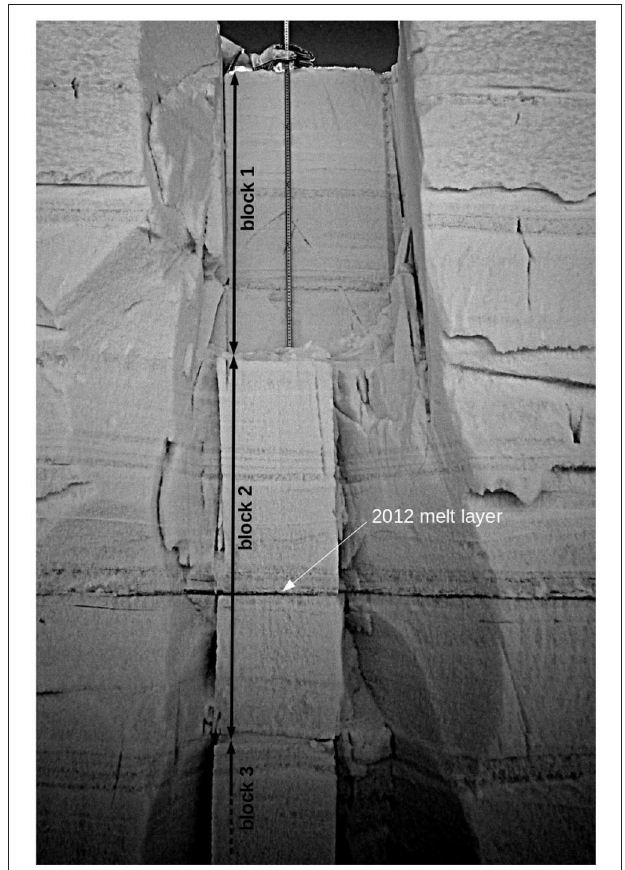
FIGURE 1 | Near-infrared picture (qualitative) of the snow wall that highlights the snowpack layering via differences in the specific surface area. Clearly visible is the melt event from 2012 as a (low specific surface area)